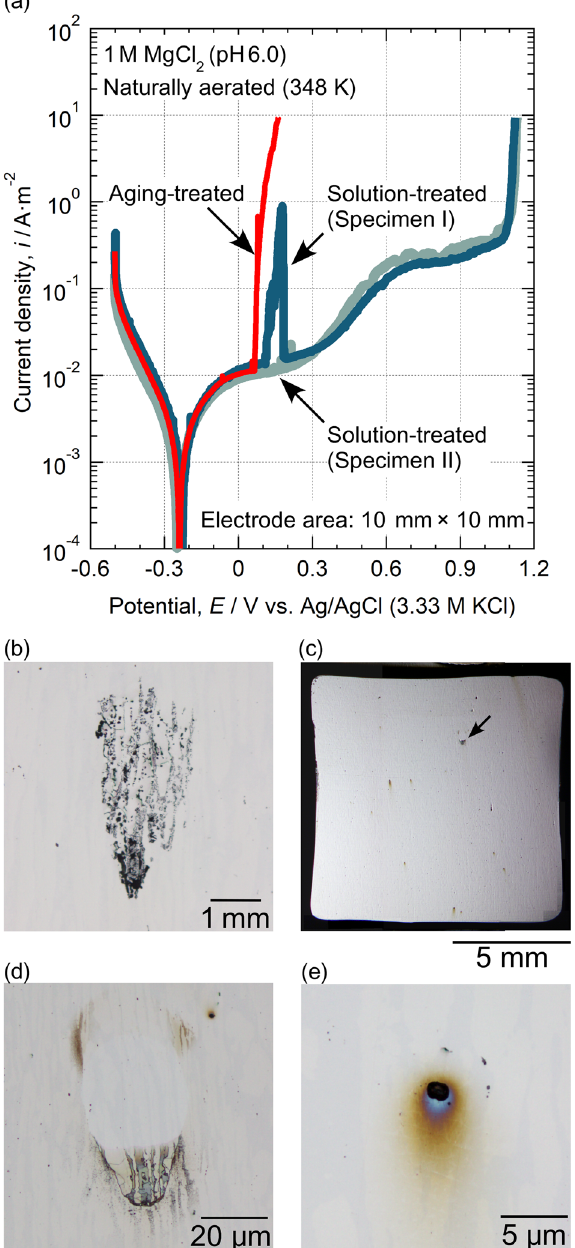
Fig. 7 Effect of aging-treatment on the pitting corrosion resistance. a Polarization curves of the solution-treated and aged specimens in naturally aerated 1 M MgCl 2 at pH 6.0 (348 K). Electrode area: 10 × 10 mm. b Optical micrograph of pitting corrosion on the aged specimen. c Optical micrograph of the electrode area of the solution-treated specimen (Specimen I) after polarization. d Enlarged view of the area indicated by the arrows in c . e Optical micrograph of localized discoloration on the solution- treated specimen (Specimen